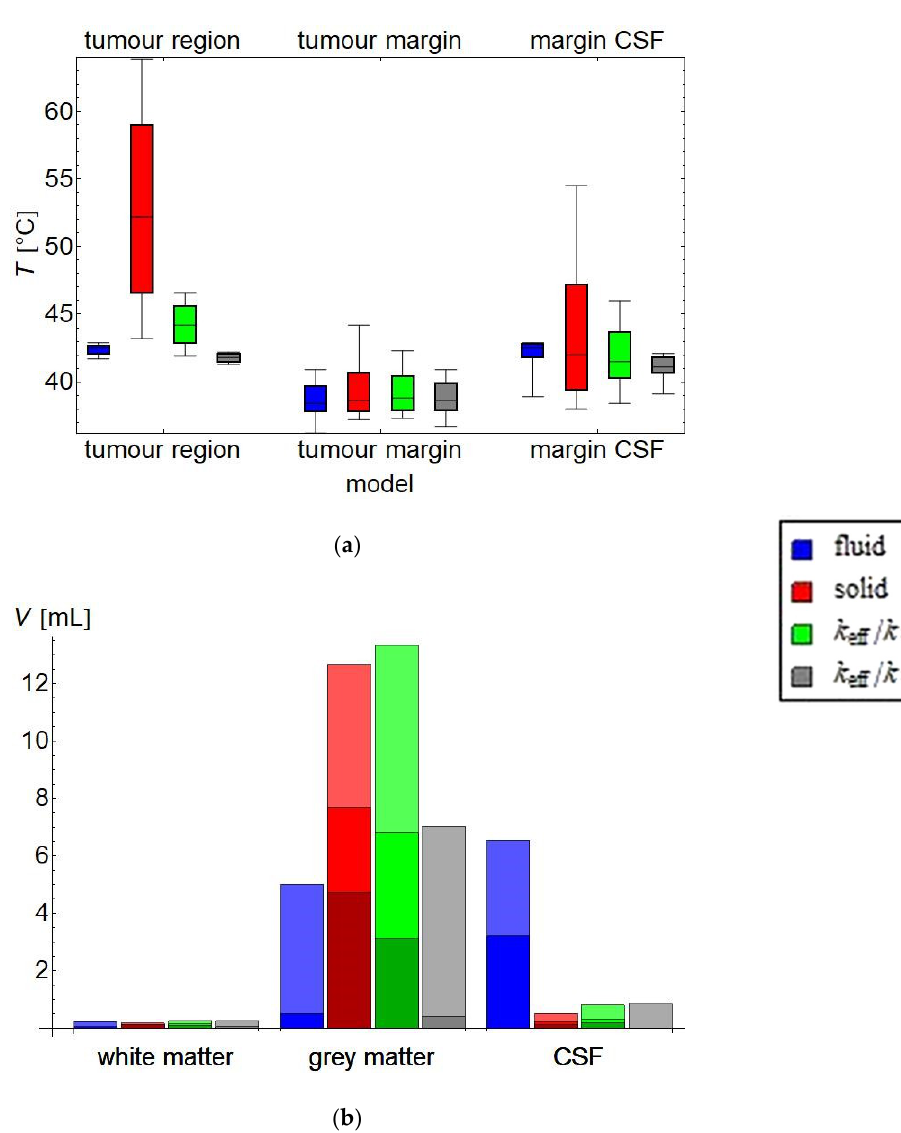
Figure 8. Analysis of treatment plan parameters for the pre-operative case. ( a ) shows the temperature distribution in the treatment target: box: inter-quartile range with median temperature T 50 indicated; whiskers: T 90 and T 10 , i.e., the temperature exceeded by, respectively, 90% and 10% of the volume. For the treatment target, a temperature in the range 42–43 ◦ C is clinically considered optimal. ( b ) shows for the healthy tissue the volume exceeding, respectively, 41, 42, and 43 ◦ C (a darker shade representing a higher temperature). Clinically, these volumes should be as low as possible. Total volume: white matter = 125 mL; grey matter = 1007 mL; CSF = 448 mL. The exact numbers are provided in Table S2.